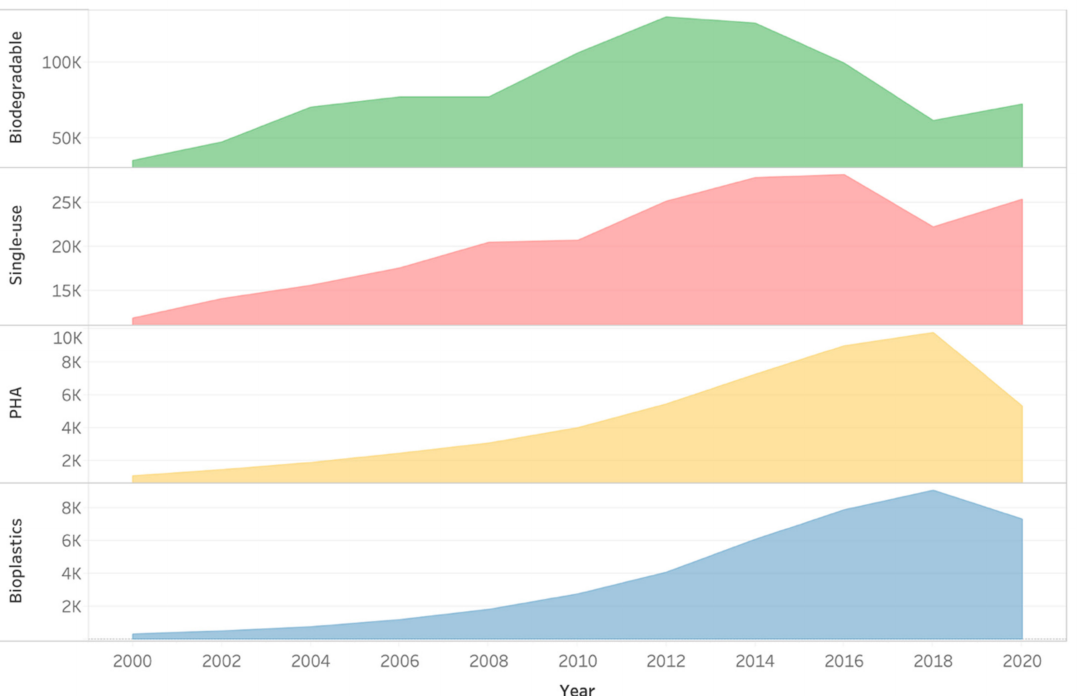
Figure 1. Timeline and milestones in bioplastic discovery and product development. Grey boxes indicate key innovations made in bioplastic research, and brown boxes show bioplastic production and applications in the context of technological advances.